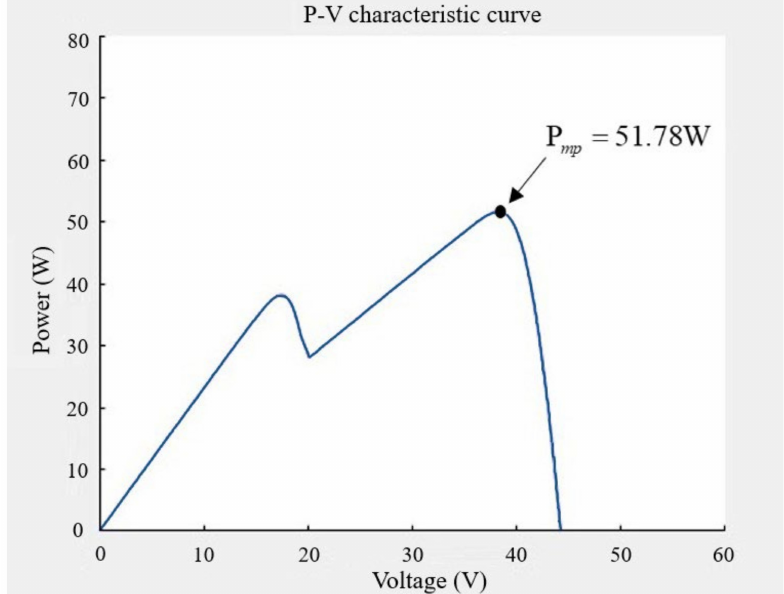
Figure 12. P–V characteristic curve simulation for Case 5.